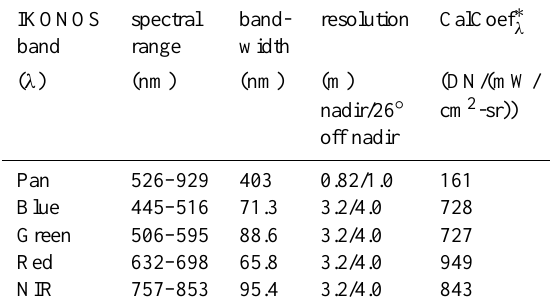
Table 1. IKONOS band dependent parameters of the scenes ac- quired on 13 January 2003, 04:11GMT (pre-tsunami) and 15 Jan- uary 2005 04:12GMT (post-tsunami), after Taylor (2009), Geo- eye (2006).